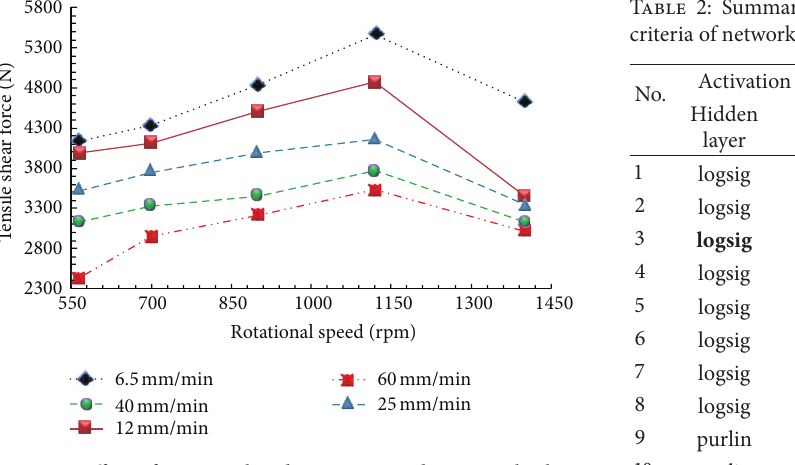
Figure 2: Effect of rotational and traverse speeds on tensile shear strength.